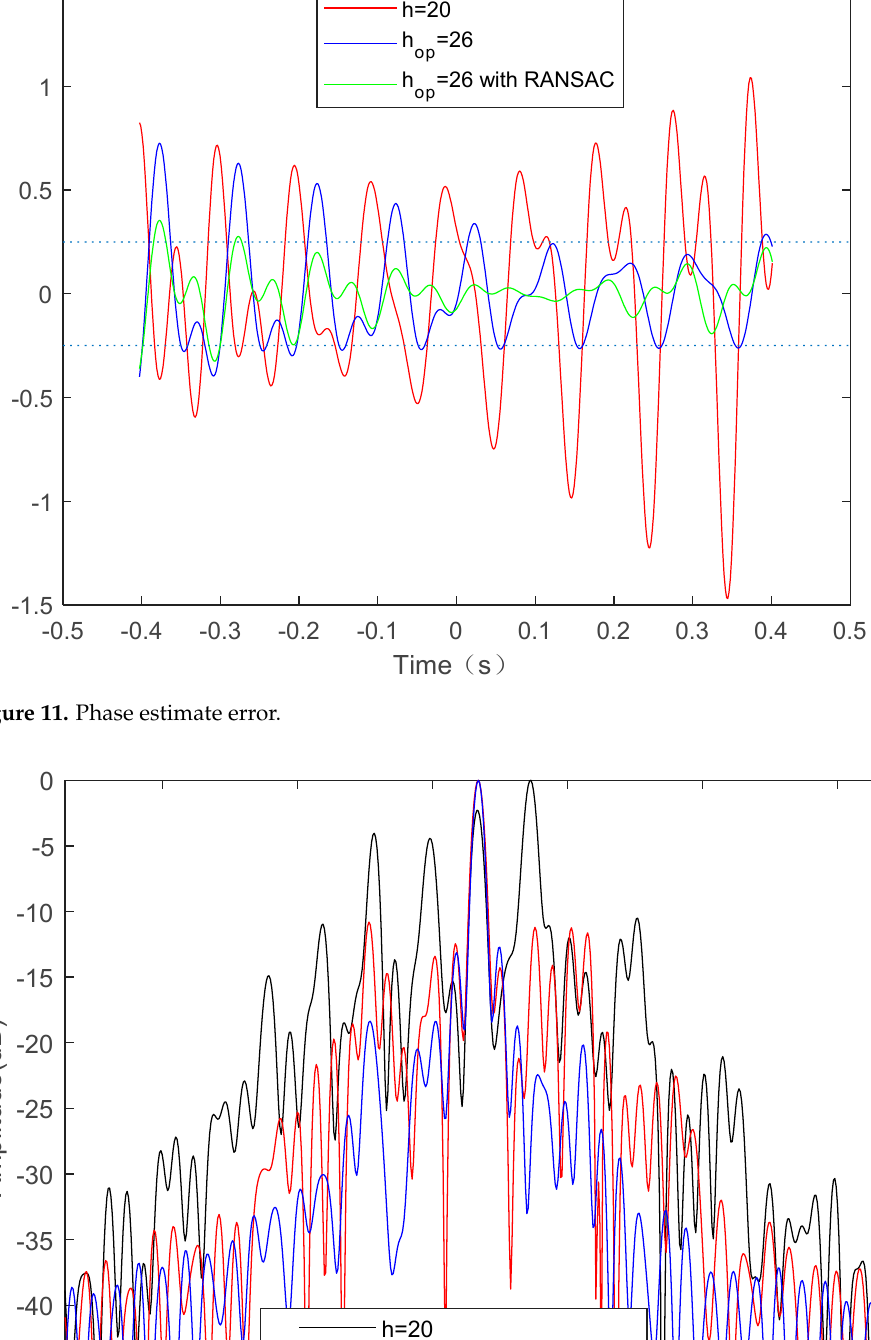
Table 5. Quality evaluation table of multi-component compensation .